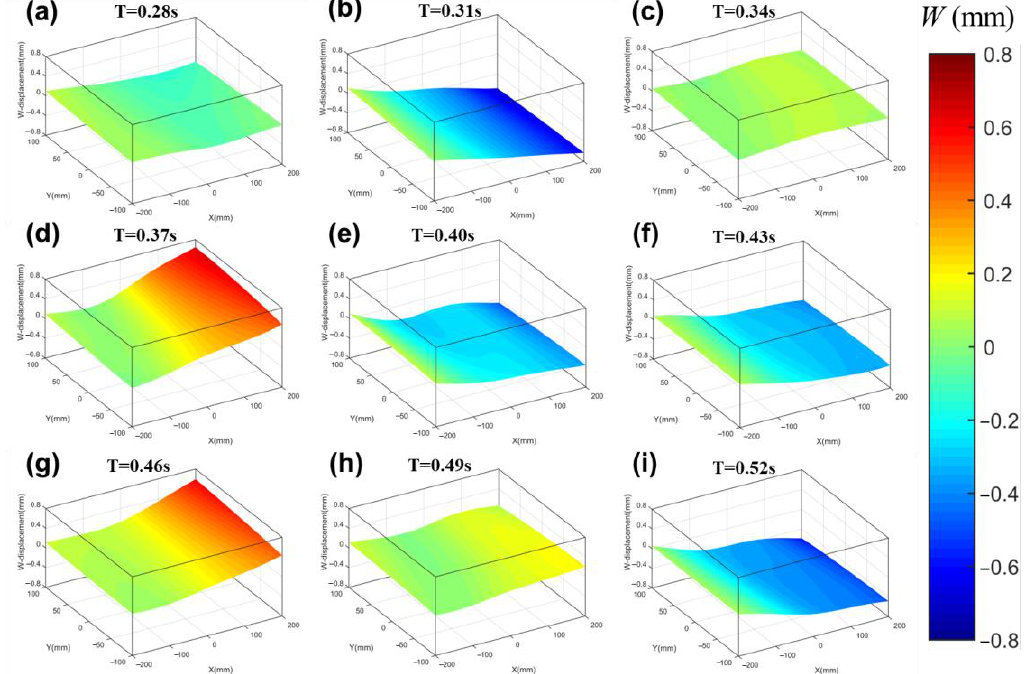
Figure 9. The out-of-plane displacement fields measured at ( a ) 0.28 s, ( b ) 0.31 s, ( c ) 0.34 s, ( d ) 0.37 s, ( e ) 0.40 s, ( f ) 0.43 s, ( g ) 0.46 s, ( h ) 0.49 s, ( i ) 0.52 s. ( e ) 0.40 s, ( f ) 0.43 s, ( g ) 0.46 s, ( h ) 0.49 s, ( i ) 0.52